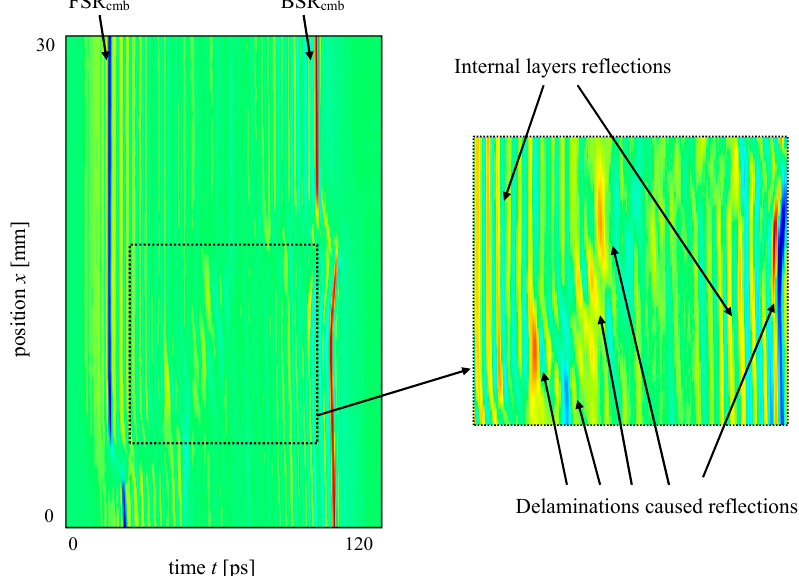
Figure 13. Combined B-scan signal g cmb ( t , x ) using the proposed algorithm.